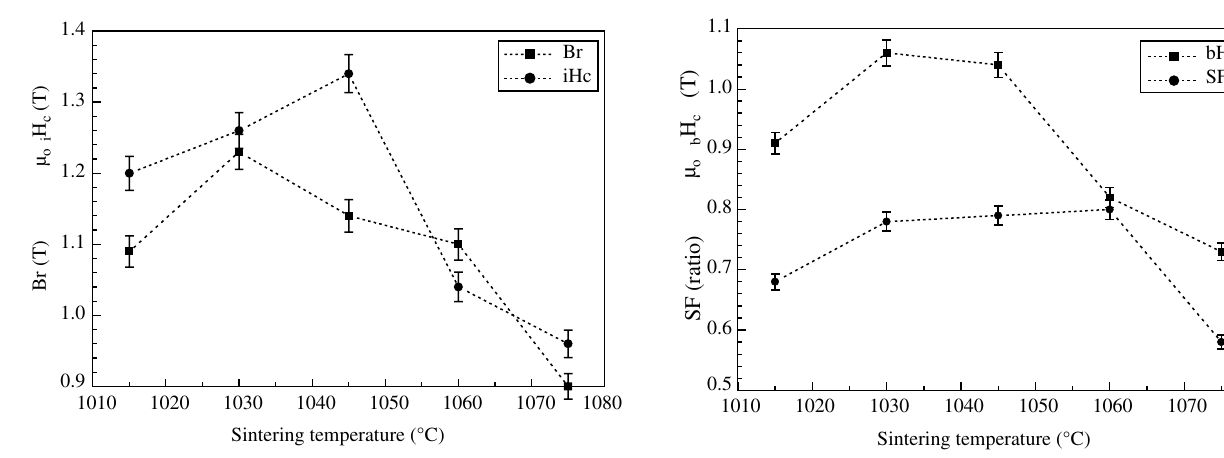
Figure 7. Inductive coercivity and squareness factor vs. sintering tempera- ture for